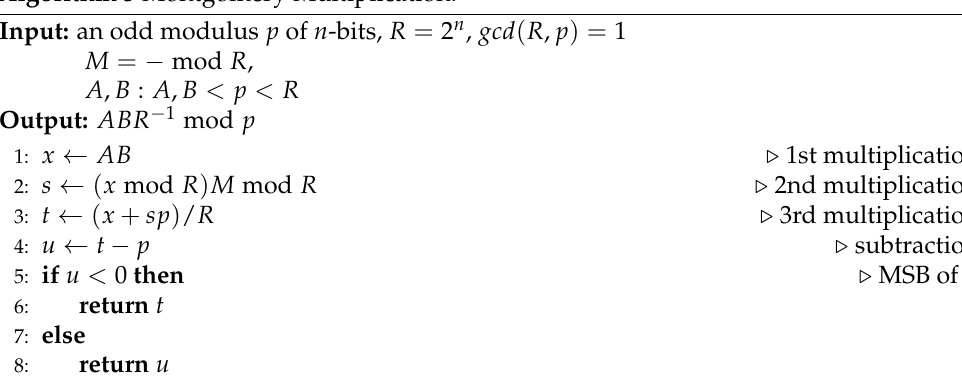
Algorithm 3 Montgomery